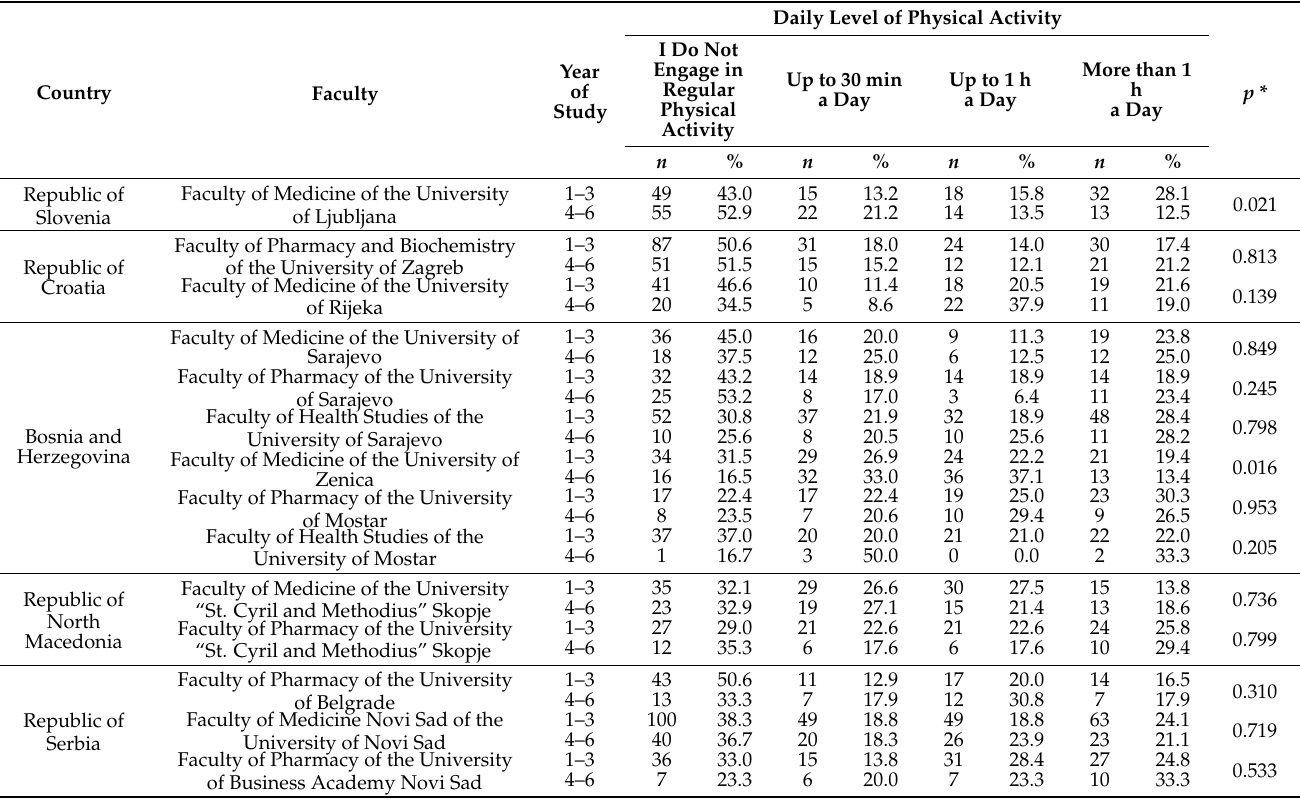
Table 5. Daily level of physical activity of medical students by year of study in relation to the attended